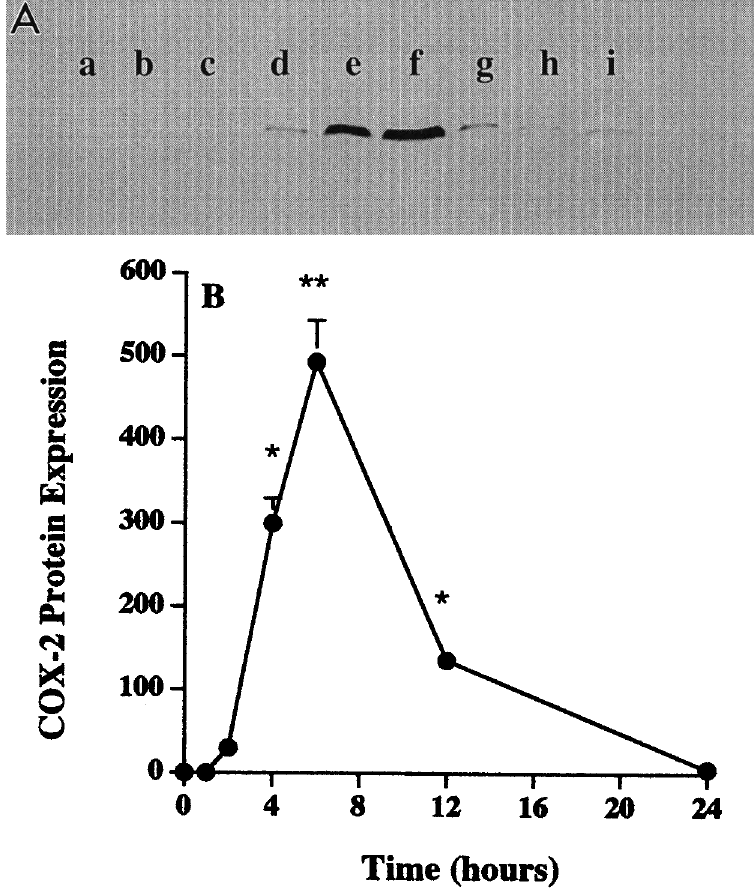
FIG. 6. (A) A representative Western blot (one of three experiments) showing induction of COX-2 (size, 70kD) protein synthesis by IL-1 b for different time periods as follows: lane a, 0min; lane b, 30min; lane c, 1h; lane d, 2h; lane e, 4h; lane f, 6h; laneg, 8h; laneh, 12h; and lane i, 24h. (B) Levels of COX-2 in cells treated with IL-1 b (10ng/ml) for 24h. * P <0.05, ** P <0.005; P value represents the comparison of the effect of IL-1 b on COX-2 levels as compared with untreated control. Data are means±SE for three separate experiments.